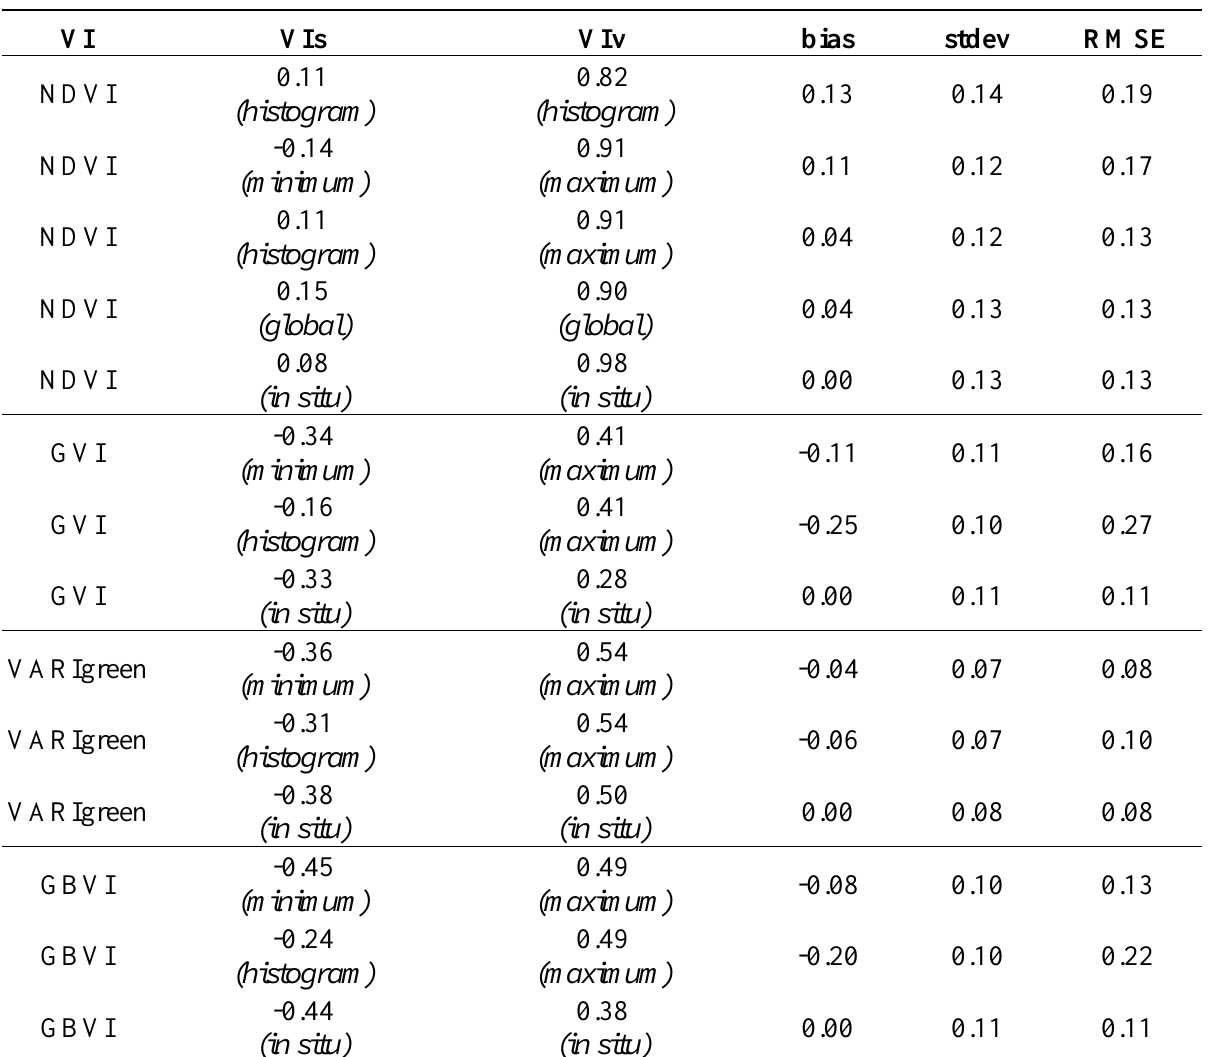
Table 4. Statistics obtained in the test of the different approaches considered for retrieving Fractional Vegetation Cover (FVC) from Vegetation Indices (VI) using Eqs. (2), (8), (9) and (10). VIs and VIv refer respectively to ‘soil’ and ‘vegetation’ values associated with each VI. The assumption considered to extract VIs and VIv values is given in brackets. ‘Bias’ is the mean difference between retrieved FVC values and in situ ones, ‘stdev’ is the standard deviation of the bias, and RMSE is the Root Mean Square Error obtained as a square sum of ‘bias’ and